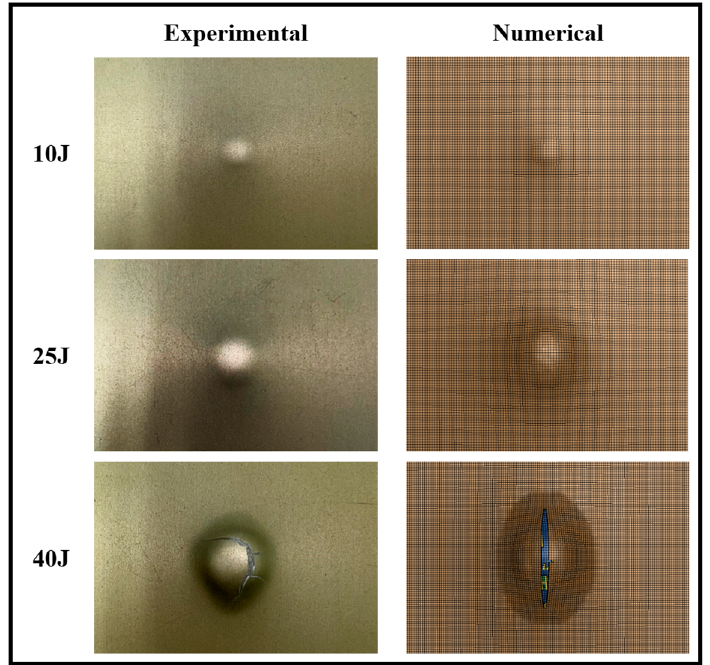
Figure 8. The low-velocity impact test results: plots of ( a ) impact force vs. time; ( b ) indentation depth vs. time; ( c ) impact force vs. displacement.